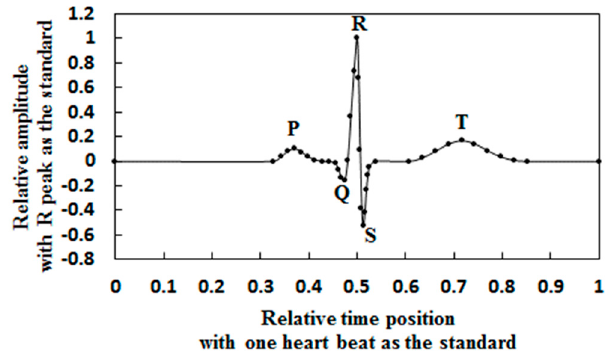
Figure 1. Dimensionless heart beat model.